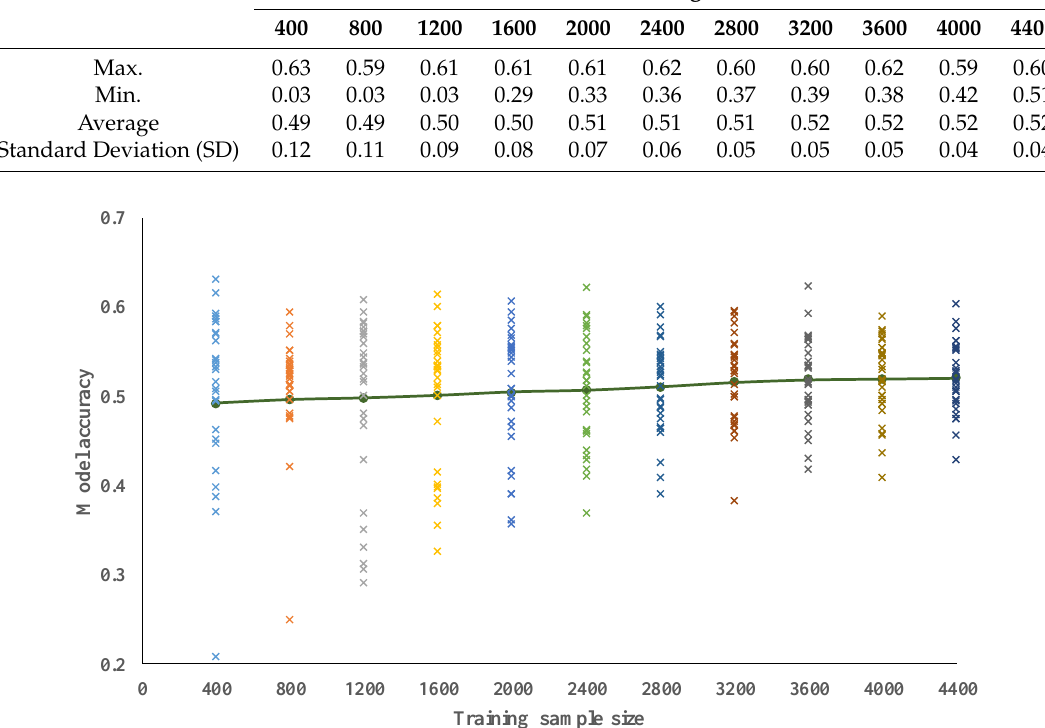
Size of Training Dataset